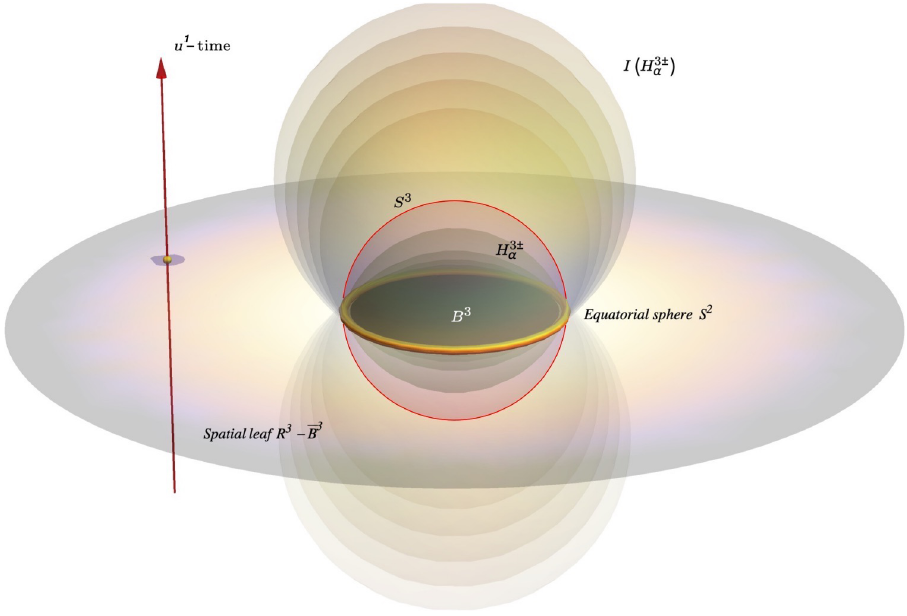
Figure 3. The foliation of spacetime with respect to group action of group (cid:98) G + τ